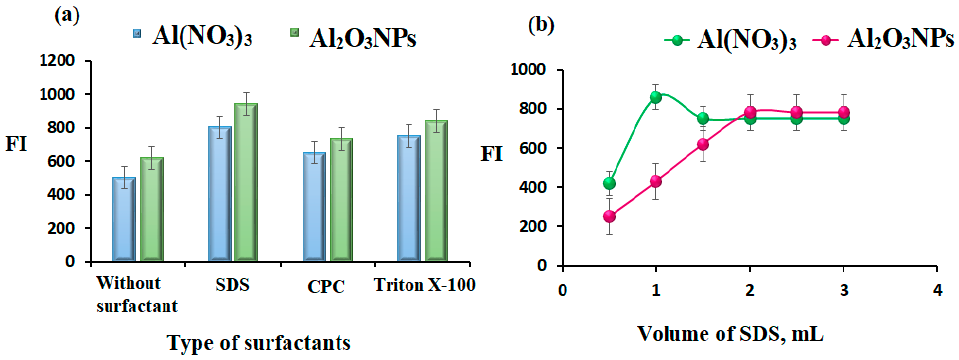
Figure 8. ( a ) Effect of type of surfactants and ( b ) effect of volume of SDS on the AMH 1.0 µ g mL − 1 using AMH-Al 2 O 3 NPs and AMH-Al(NO 3 ) 3 complex systems.